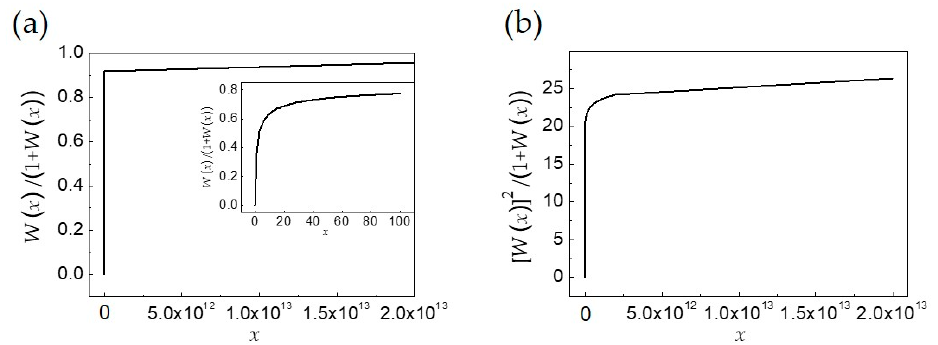
Figure 1. ( a ) Plot of W ( x )/(1 + W ( x )) function for the whole interval of integration 0 ≤ x ≤ C , with C = 2.0 × 10 13 . Inset: Plot of W ( x )/(1 + W ( x )) function in the interval 0 ≤ x ≤ 100. ( b ) As in ( a ) but for [ W ( x )] 2 /(1 + W ( x )).